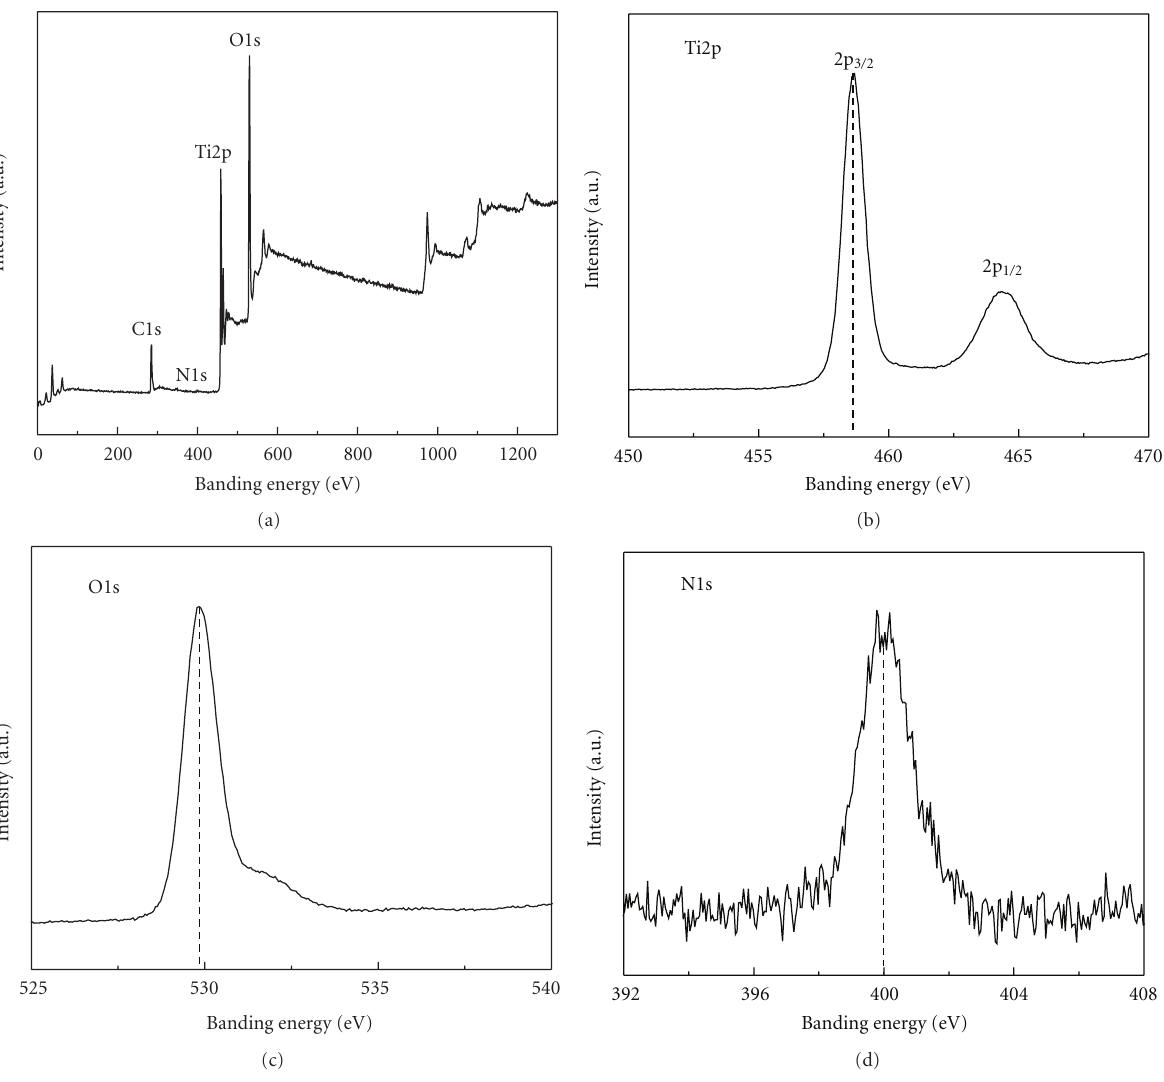
Figure 6: XPS spectra of the N-doped TNT arrays sample. (a) A survey spectrum, (b) a spectrum of Ti 2p, (c) a spectrum of O 1s, and (d) a spectrum of N 1s. The doping conditions are that reaction voltage is 3 V, reaction time 3h and electrolyte concentration 0.5 M.